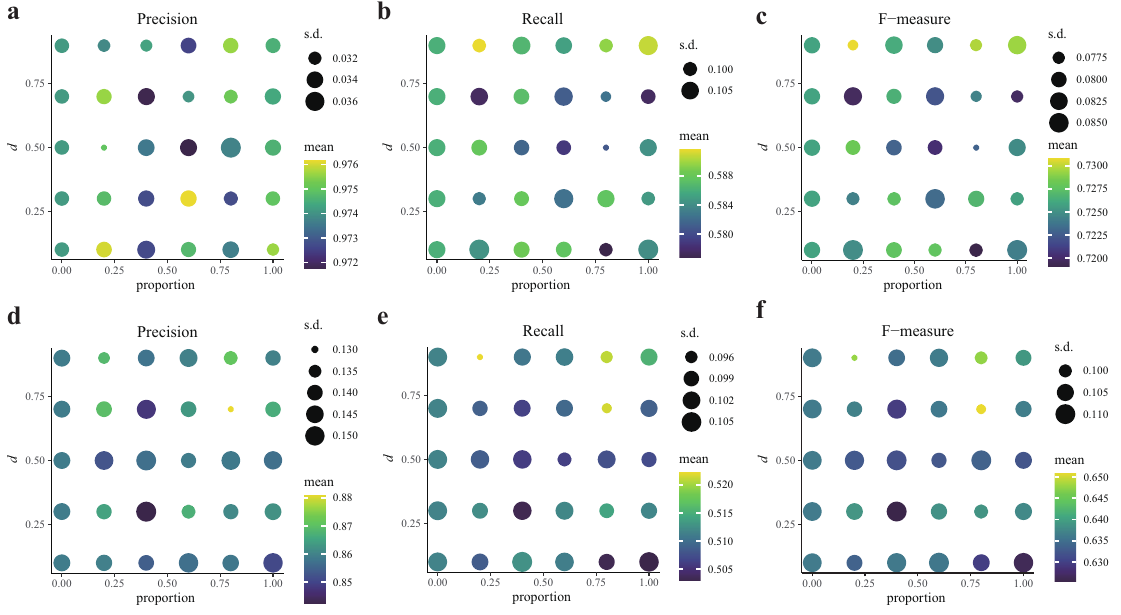
Figure 3. Comparisons of different set-ups of asynchronous simulations. ( a – c ) The results of discov- ering causal pairs. ( d – f ) The results of determining causal directions. d indicates the range of the random